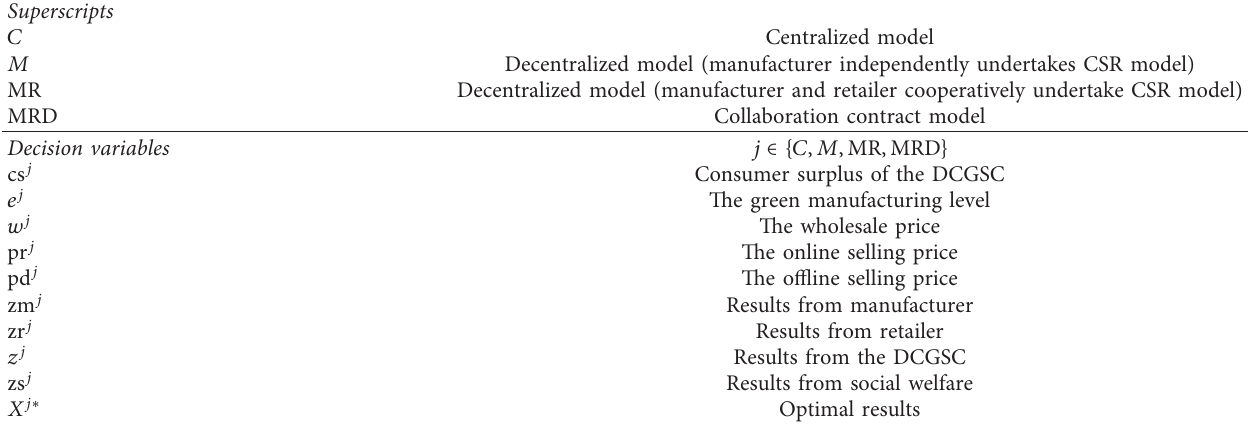
Table 1: List of superscripts and decision